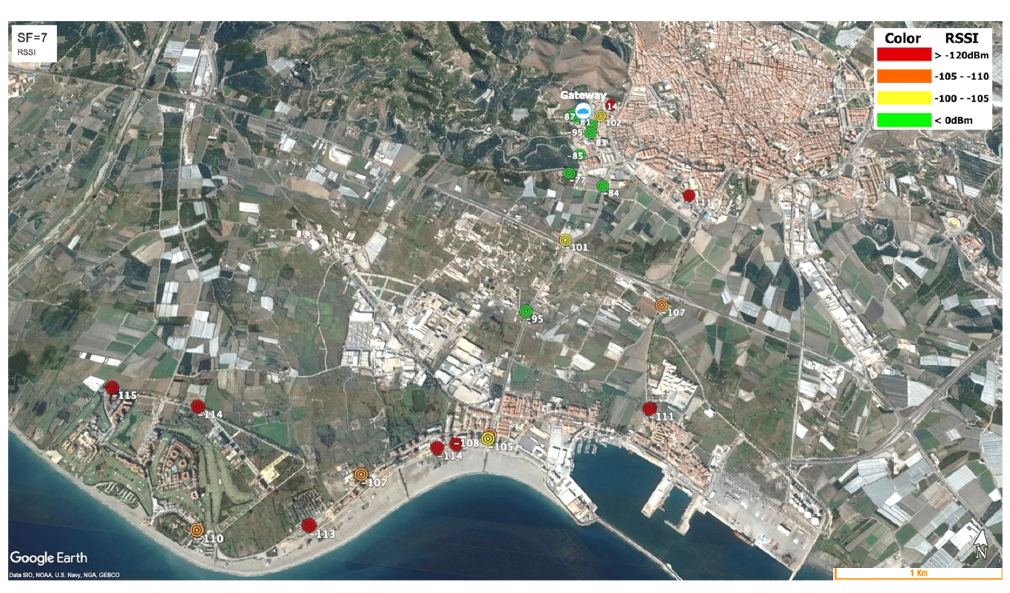
Figure 17. Results of RSSI measured in the scenario.